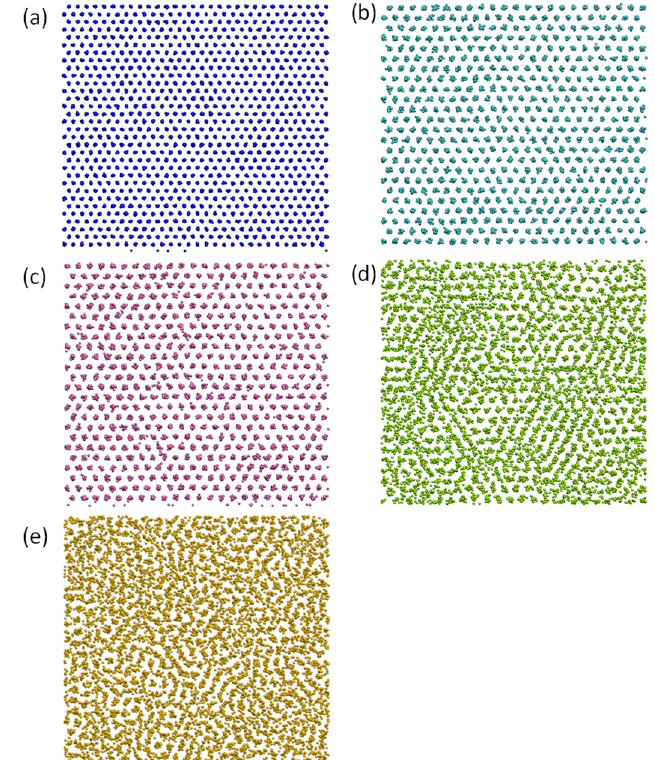
Figure 2. Time-averaged atomic positions showing the atomic arrangement in the Pb( l )/Cu( s ) system equilibrated at 625 K (above the melting temperature of Pb (618 K)). ( a ) First Cu layer (L1Cu); ( b ) the CSL Pb layer (CSL, coincidence site lattice); ( c ) the 1st (L1Pb), ( d ) 2nd (L2Pb) and ( e ) 3rd (L3Pb) layers of Pb at the interface. These results suggest that there exists a 2D ordered structure in the liquid Pb induced by the Cu substrate.